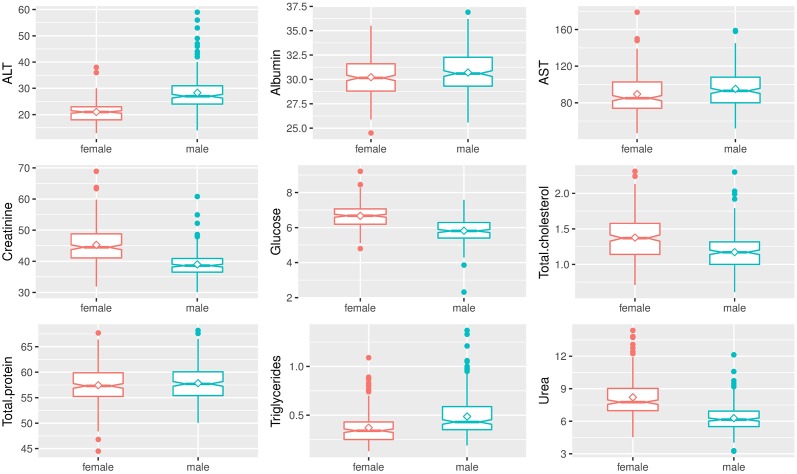
Box and whisker plots show differences in analyte levels of male and female Sprague-Dawley rats on biochemical parameters.Data were depicted as box plots that indicated the median, 25th and 75th percentiles (box), mean (◇), and 1.5 times of interquartile (whiskers). Male rats were indicated by a green line, and female rats were indicated by a red line.